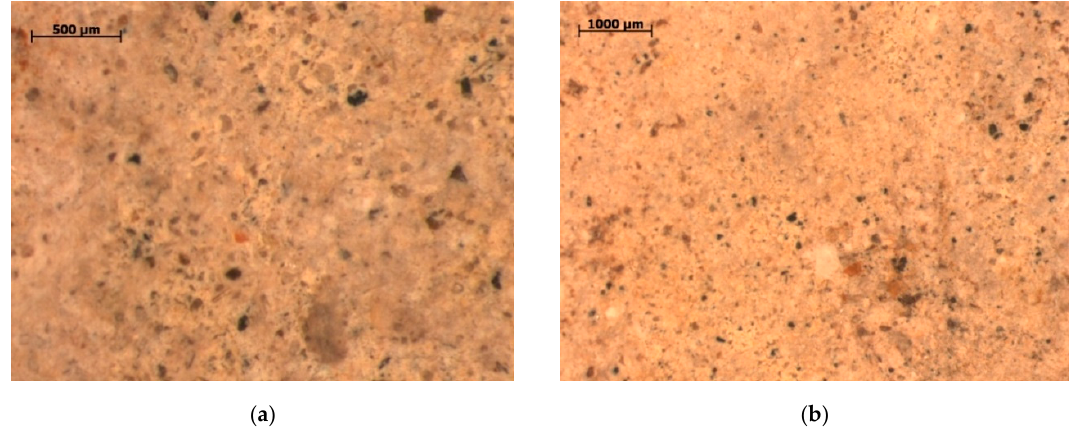
Figure 8. The structure of diatomaceous earth from the Jawornik deposit (LM). Dark areas show iron oxide impurities ( a ), whereas orange areas show clay minerals, and white are quartz particles ( b ).